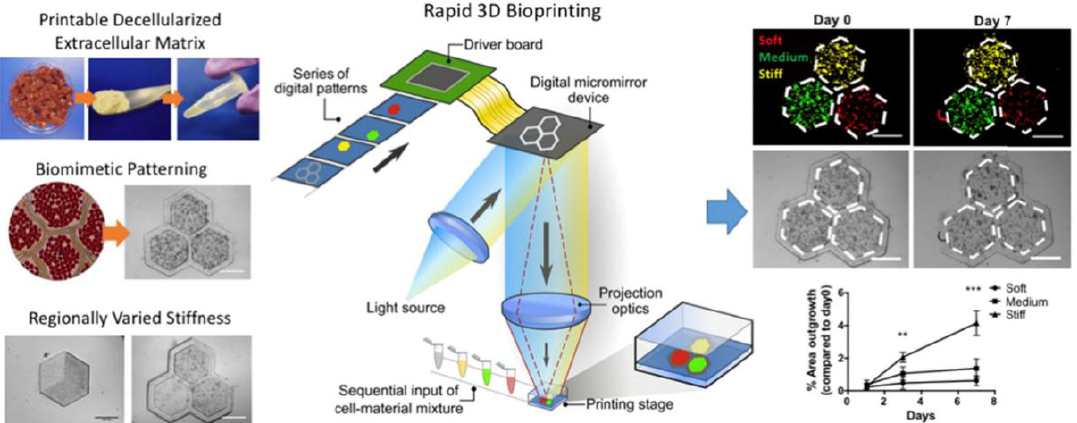
Figure 5. 3D printing of decellularized liver matrix with biomimetic morphology and user-defined patterning of regional stiffness. Greater stiffness resulted in enhanced tumor cell invasion into surrounding regions (bottom right). Adapted with permission from [60], 2018, Ma et al.